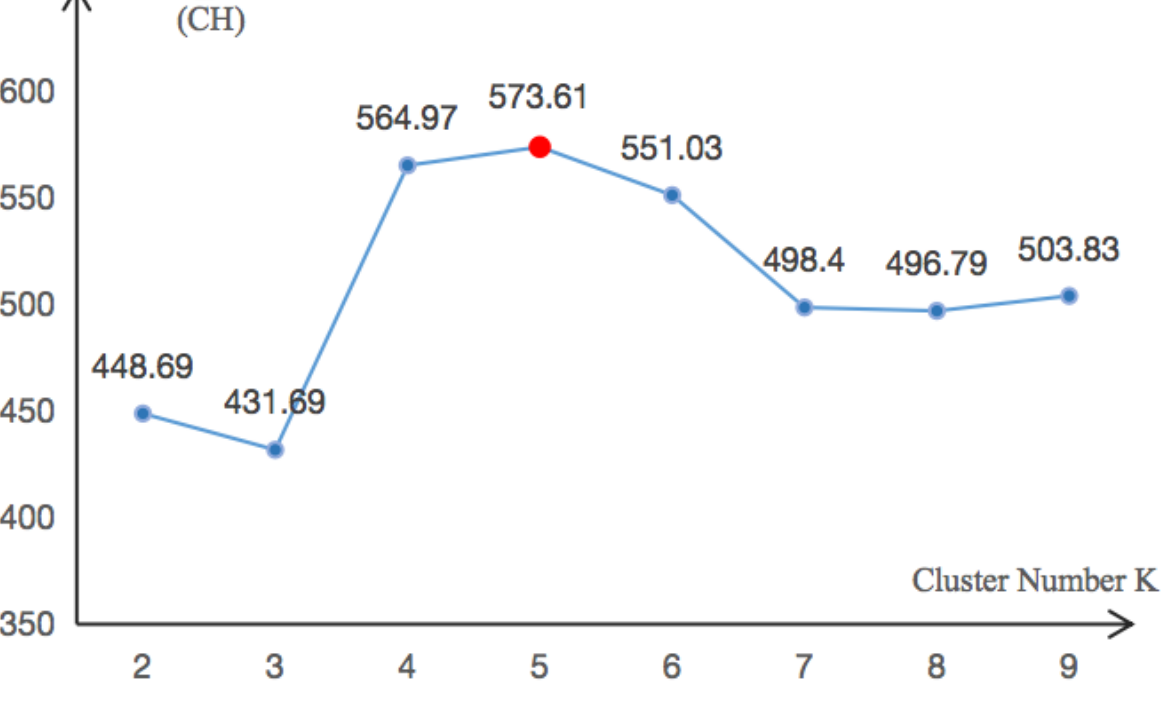
Figure 4. The CH values for different numbers of